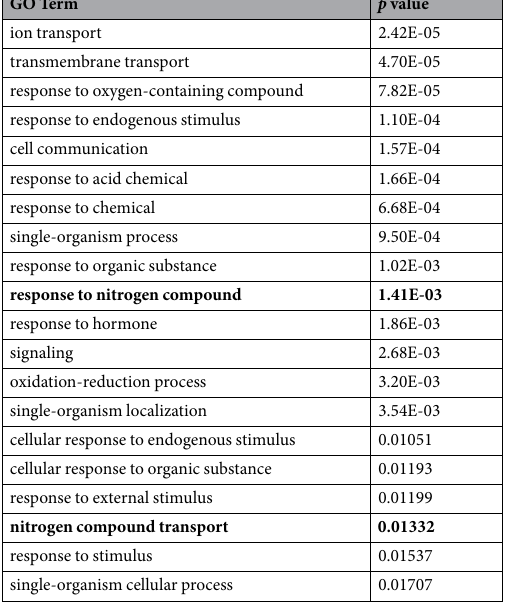
Table 2. GO analysis for the nitrate responsive genes that are modulated only by NLP7 .